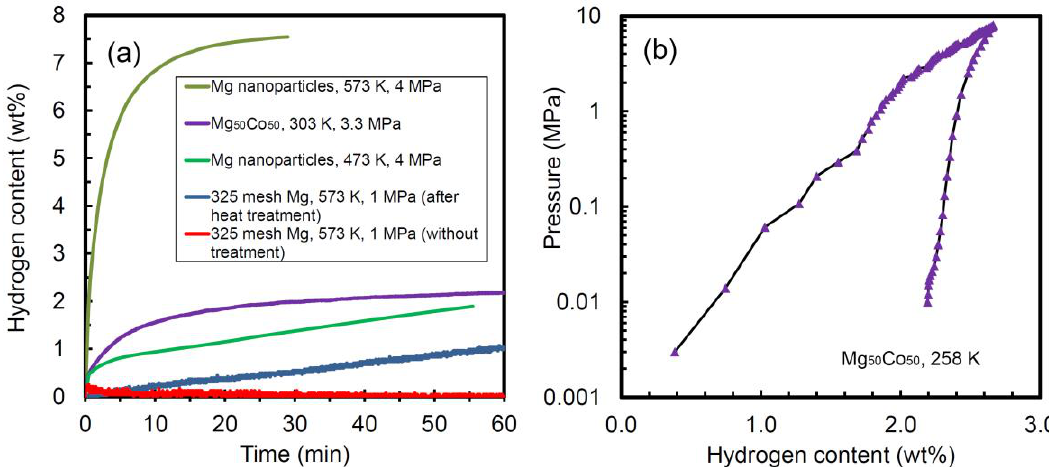
Figure 5. ( a ) Hydrogen absorption curves of Mg-based samples in different hydrogen atmosphere and temperature conditions and ( b ) pressure-composition isotherm at 258 K of the ball milled Mg 50 Co 50 BCC structure alloy. Adapted with permission from [44], Copyright Elsevier, 2014.